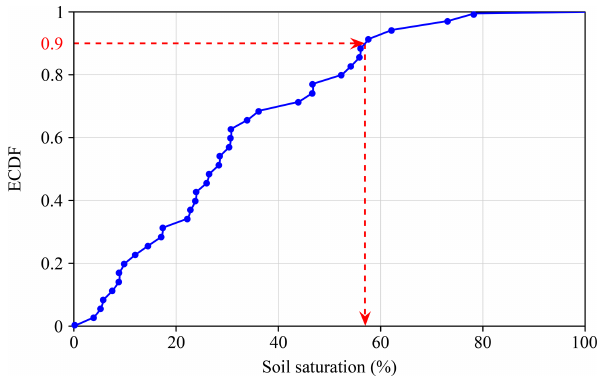
Figure 8. Example of ECDF curve for the soil saturation (relative HGR3 state variable) and extraction of the value corresponding to a non-exceedance probability of